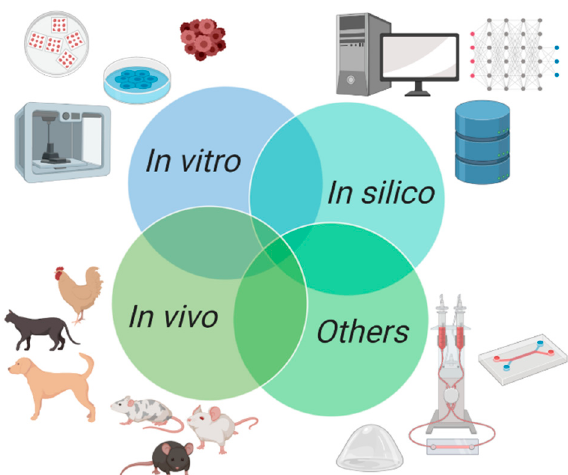
Figure 2. Schematic representation of experimental models currently available for breast cancer research, which are classified as in vitro models, in vivo models, in silico models, and others, including phantoms and 3D microfluidic chips.